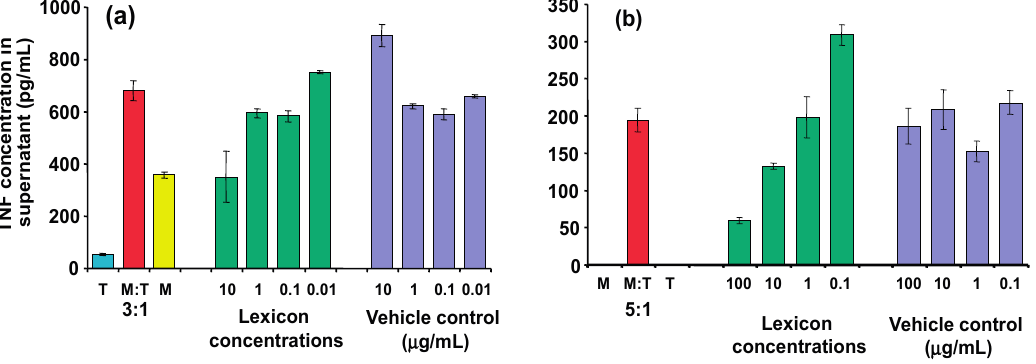
Figure 7. ( a ) Effect of Lex 2.6 at different concentrations on IL-6 secretion of LPS-stimulated J774A.1 cells; ( b ) Effect of Lex2.6 at different concentrations on IL-6 secretion of cells